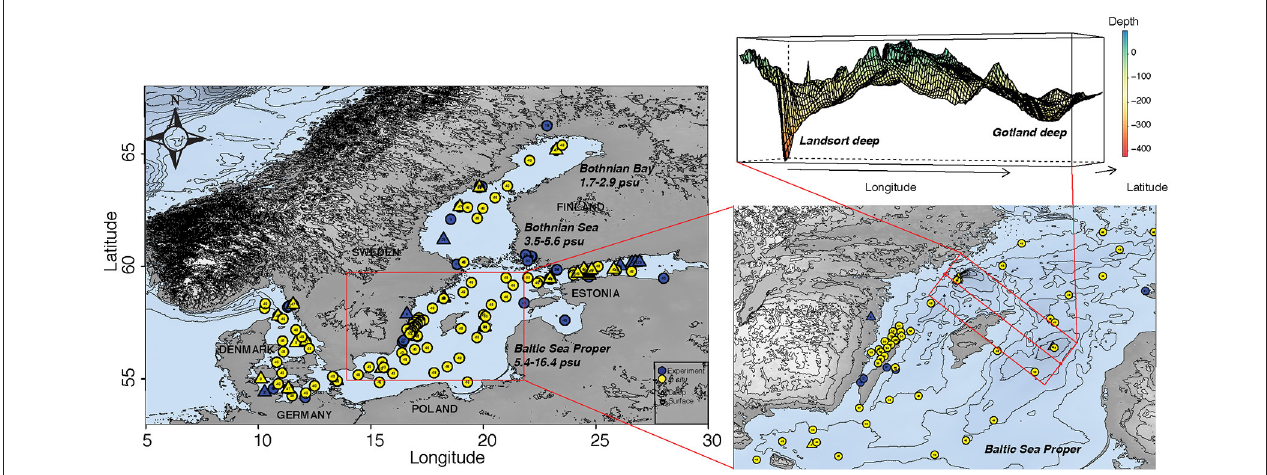
FIGURE 1 | Map showing in situ transects and temporally sampled stations (yellow symbols) and all stations that have been sampled for use in experimental studies with empirical evidence for the effect of natural or human-induced changes in environmental conditions on bacterioplankton community dynamics (blue symbols). Filled circles and triangles denote samples obtained from surface waters and from deep-water/sediment, respectively. Insert is a zoomed in map of the central Baltic Sea Proper with particularly many samples obtained, and a 3D rendition of the Gotland and Landsort Deep, frequently sampled to retrieve deep water and sediment samples. Dashed lines indicate boundaries for the three major basins; Bothnian Bay, Bothnian Sea and the Baltic Sea Proper. The map and bathymetry was produced using the package “marmap” ( Pante and Simon-Bouhet, 2013) in R V.3.4.4 (R Core Development Team, 2017) and the bathymetry data was retrieved from NOAA